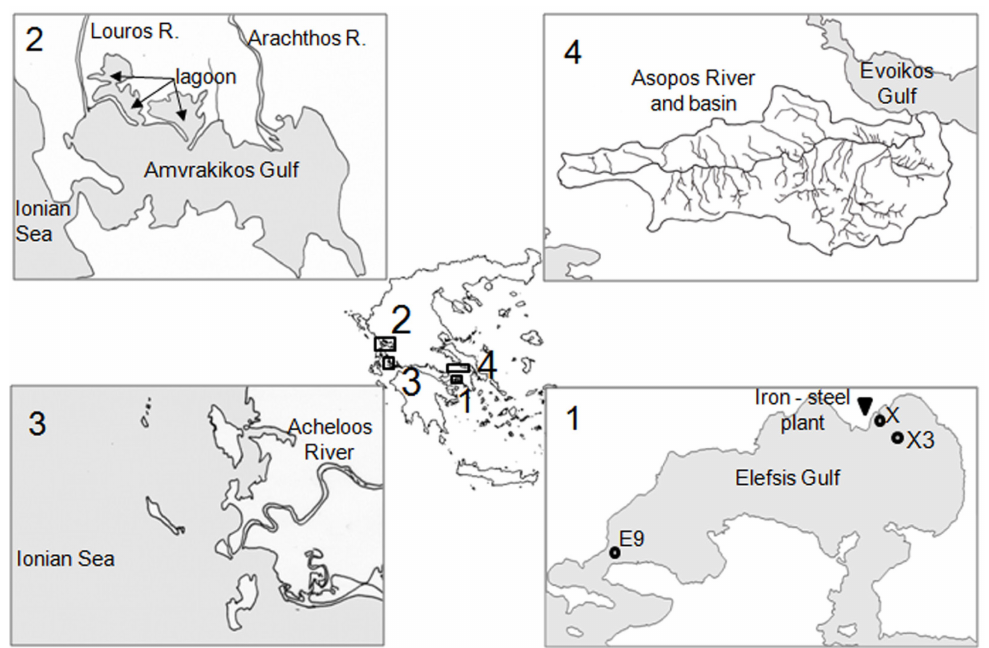
Figure 2. Location of the studied